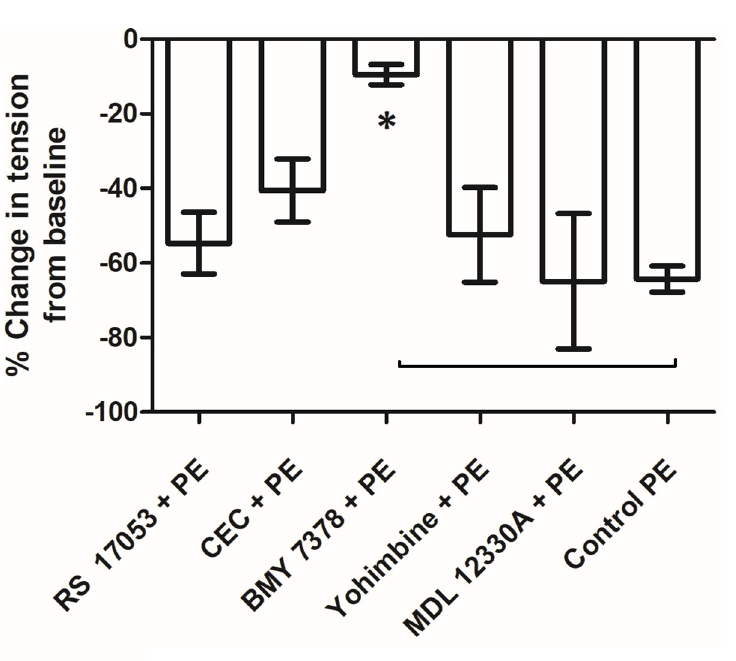
Fig 9. Bar diagram representing percent change in tension from baseline due to PE in the presence of blockers in longitudinal strip preparation of small artery. BMY 7378 an alpha 1D blocker, blocked the relaxant response to PE in a statistically significant manner (P value < 0.05 with MWU